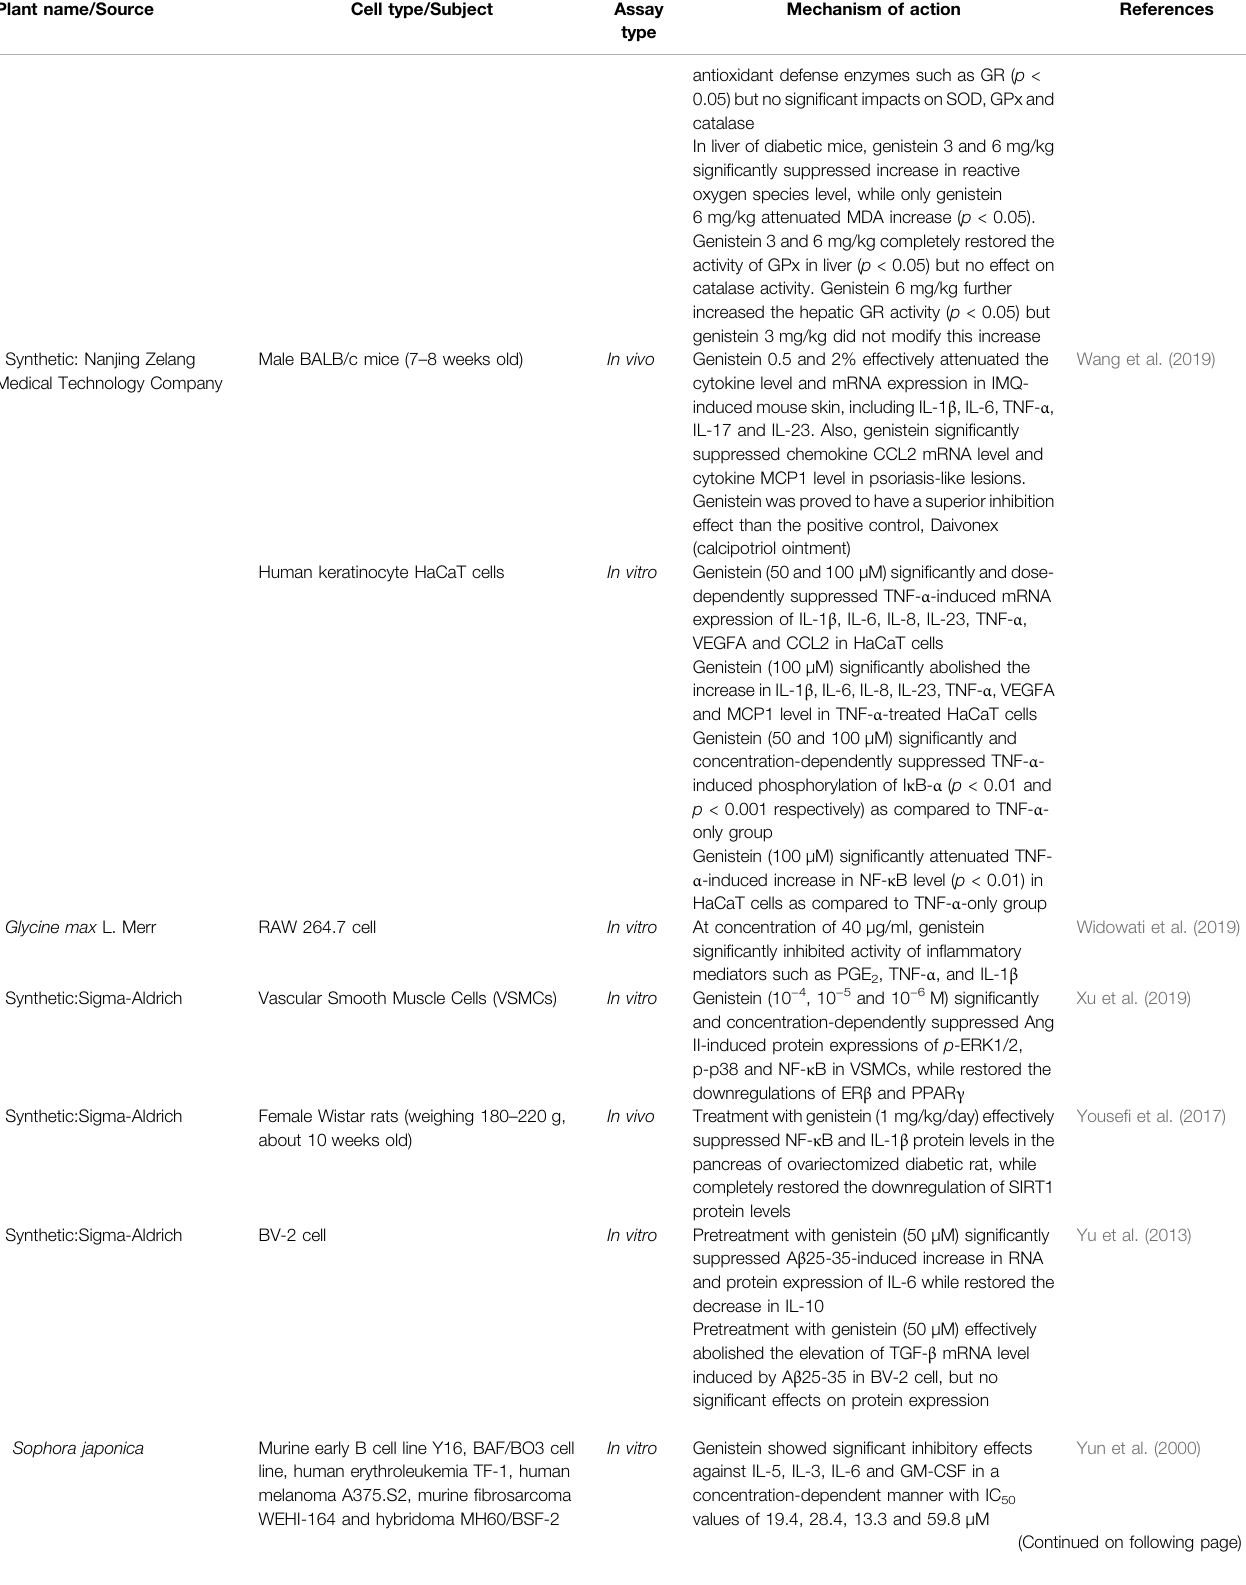
TABLE 1 | ( Continued ) Genistein with potent anti-in fl ammatory